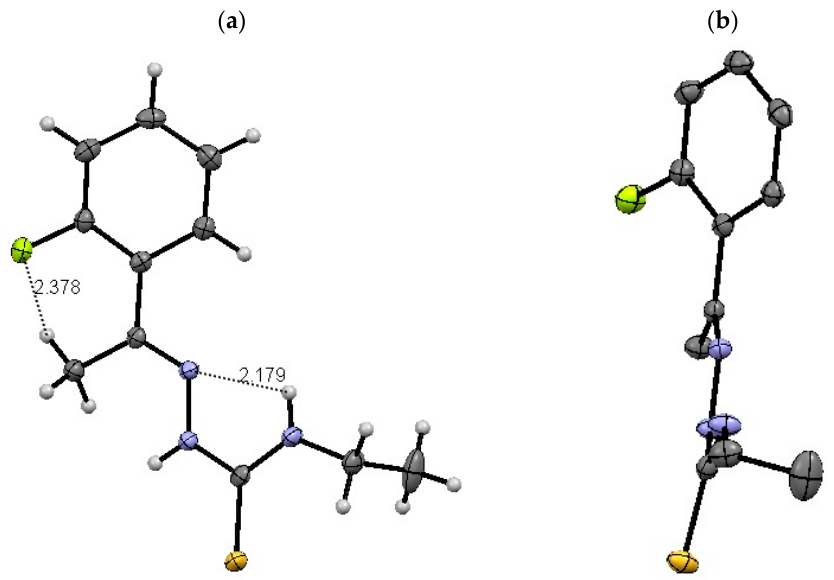
Figure 2. ( a ) Intramolecular interactions between F(1)-H and N(1)-H. ( b ) Deviation of the phenyl ring from the thiosemicarbazone plane.